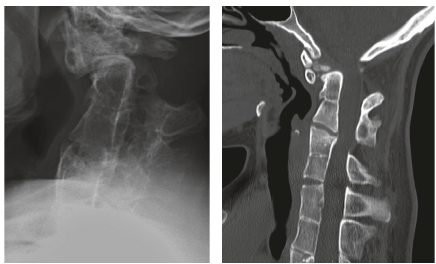
Figure 3: Lateral cervical spine and sagittal CTscan of the cervical vertebrae showing fusion of C2-C3, C4-C5, and C6-C7.